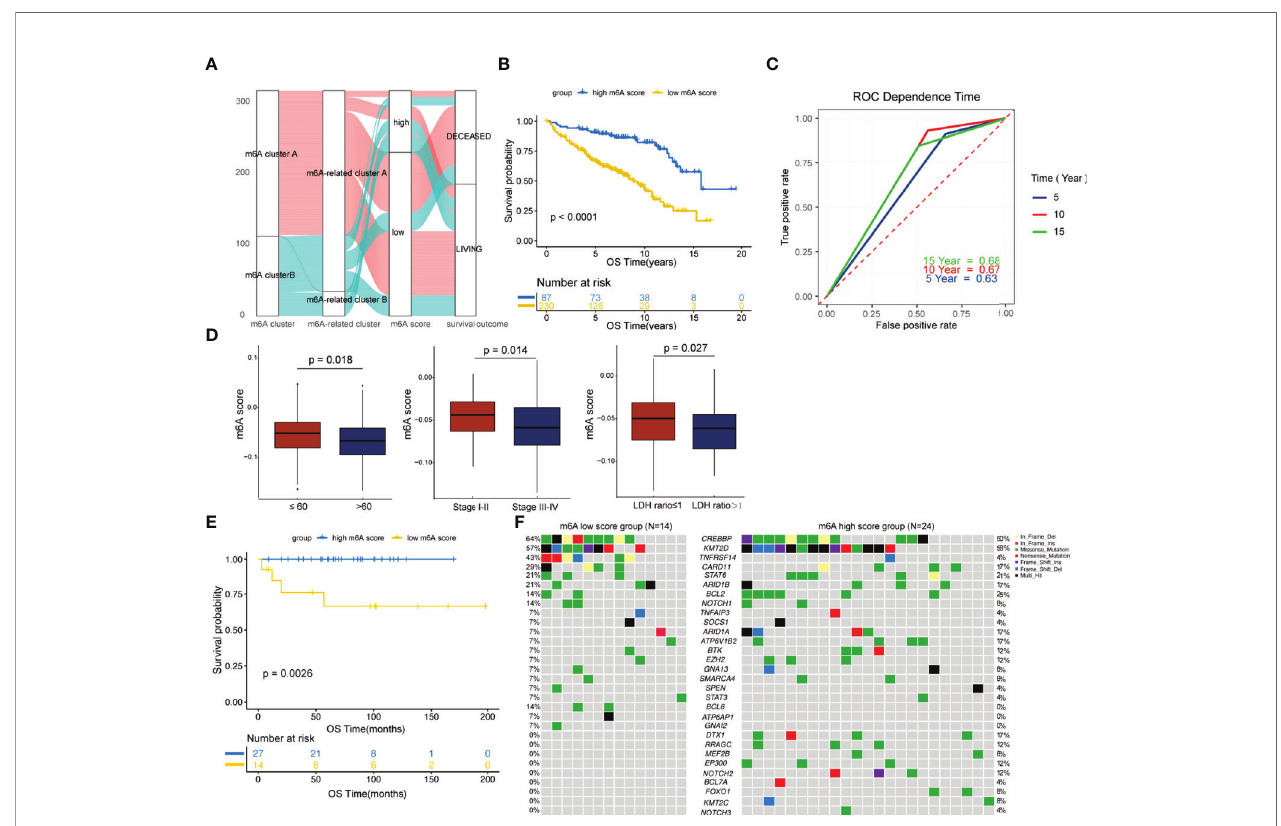
FIGURE 3 | Development and validation of the m6A score. (A) Alluvial diagram showing the changes in m6A clusters, m6A-related clusters and m6A scores. (B) Comparison of survival curves between the high and low m6A score groups by the log-rank test. (C) The predictive value of the m6A score for survival evaluated by time-dependent ROC curves. (D) Differences in the m6A score among distinct clinical subgroups. (E) Validation of the prognostic value of the m6A score in an external cohort. (F) The waterfall plot depicted tumor somatic mutations of patients with low and high m6A scores in the external